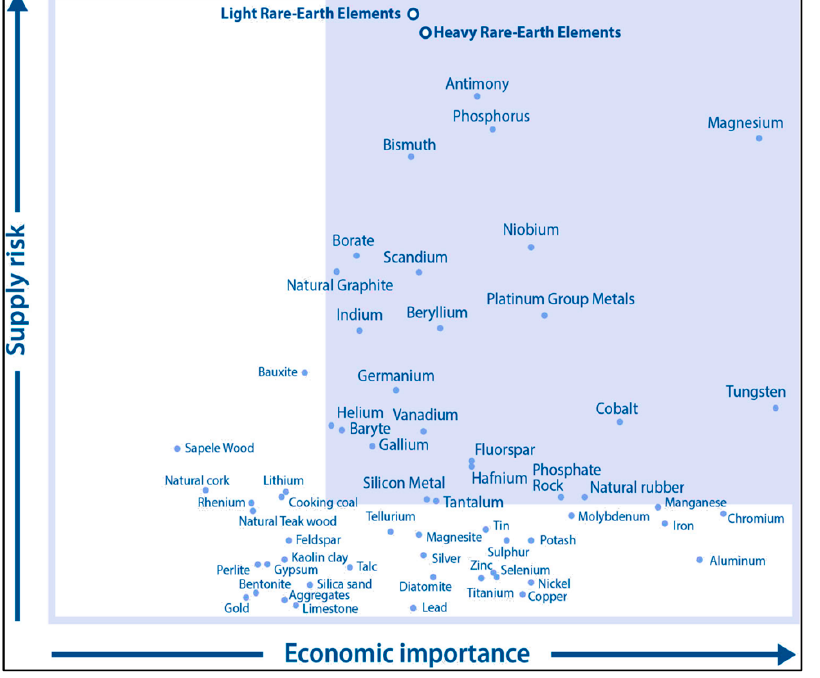
Figure 1. Diagram illustrating the critical metals according to EU reports [8] based on economic importance and supply risk (after Binnemans al.